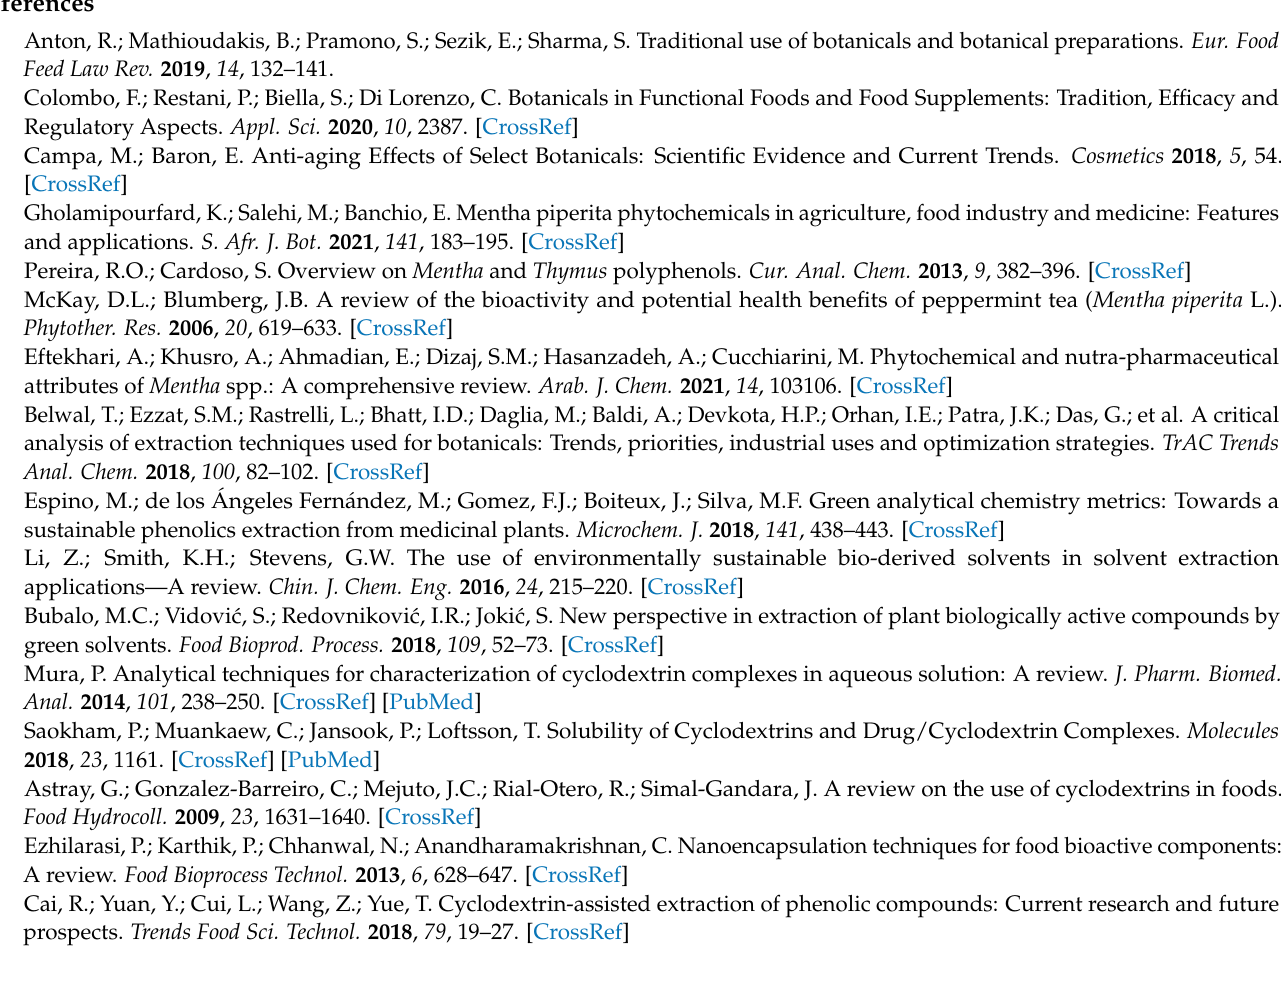
of predicted vs. actual values of the response (AAR) (plot B), for the optimization of the extraction of M. piperita polyphenols performed with β -CD. Inset tables provide statistics associated with the assessment of the model derived. Values with color and asterisk are statistically significant; Figure S4: Desirability function (graph A), and plot of predicted vs. actual values of the response (PR) (plot B), for the optimization of the extraction of M. piperita polyphenols performed with β -CD. Inset tables provide statistics associated with the assessment of the model derived. Values with color and asterisk are statistically